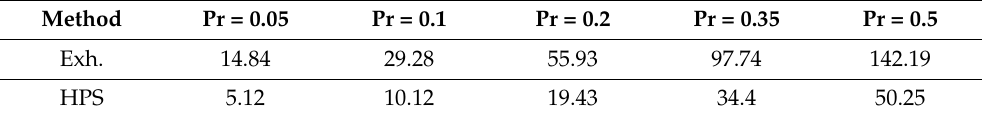
Table 4. Computation time in seconds for the pruning process in the alternative architecture.